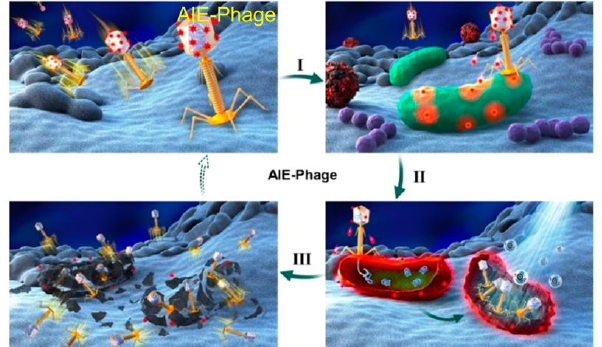
Figure 7. Phage-guided targeting, discriminative imaging, and synergistic killing of bacteria by AIE bioconjugates. The processes are as follows: ( I ) the particular recognition of bacteria by AIEgen conjugated phage; ( II ) the bacterial lighting up imaging by AIE fluorescence and the phage infections as well as the ROS generation of luminogens with aggregation-induced emission (AIEgens); ( III ) the synergistic killing of the target bacteria by phage infections and AIE-based photodynamic inactivation. Adapted and modified with permission from reference 57 (copyright 2020, American Chemical Society).